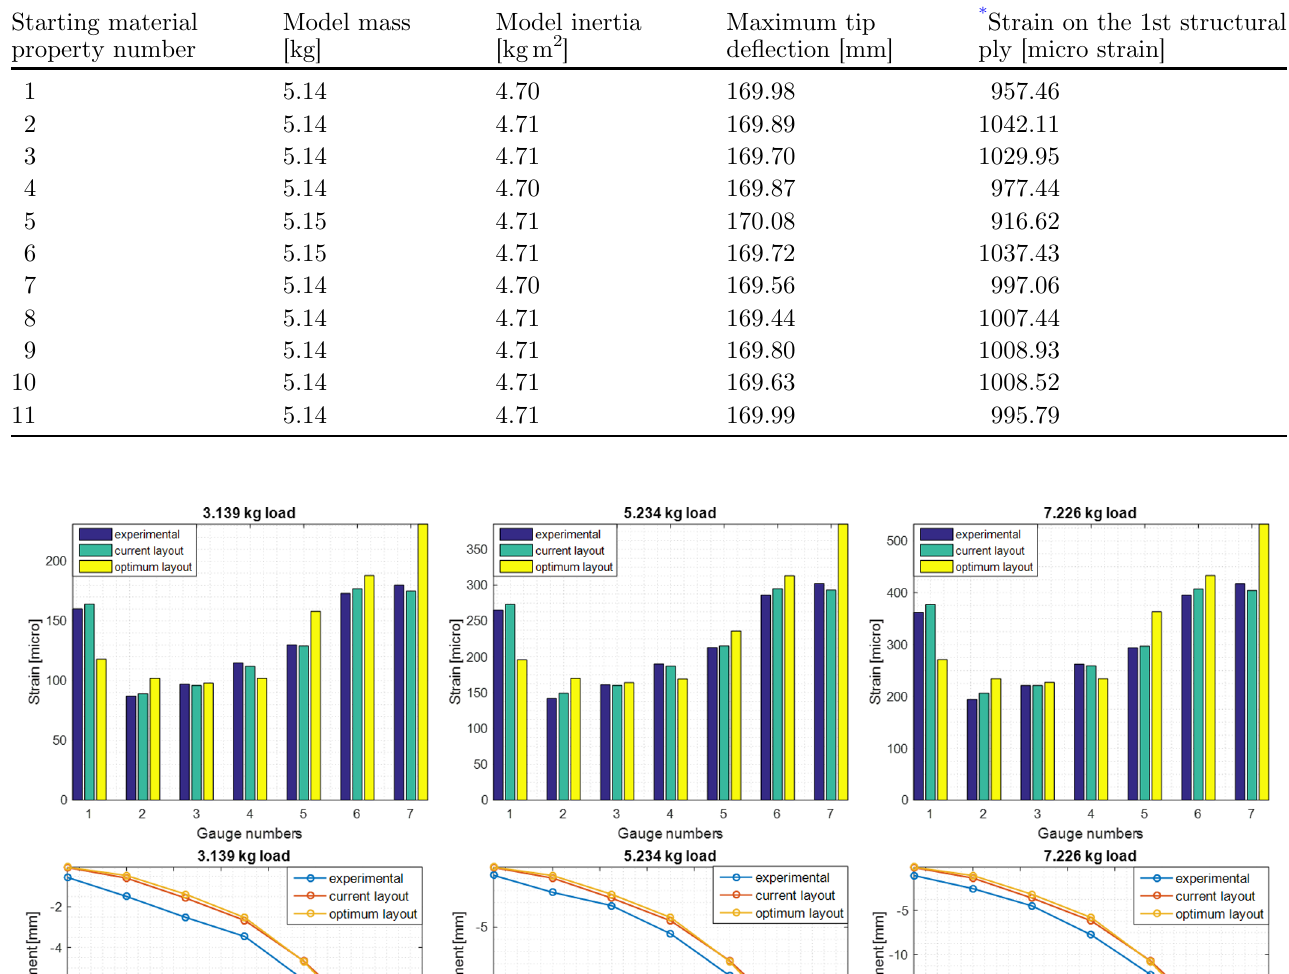
Table 2. Equivalent optimum models data.